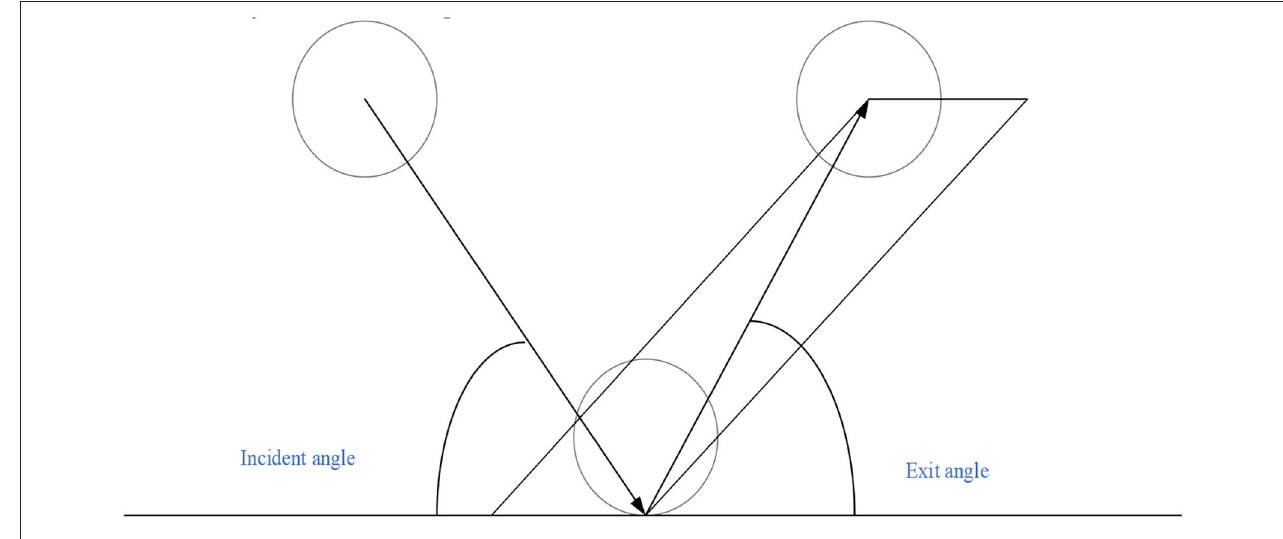
FIGURE 6 | Return state of the tennis sports robot.